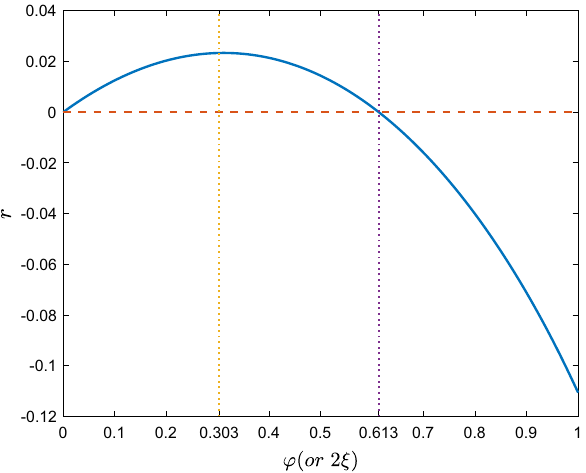
Fig. 3 The maximum r m of the violation ratio r , as a function of the parameter η , for entangled Λ ¯ Λ pairs with polarization